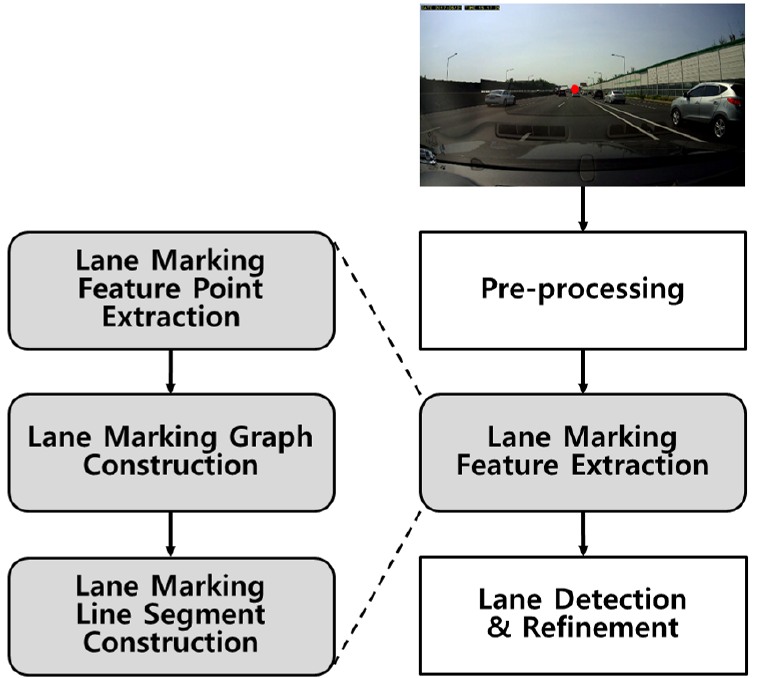
Figure 1. Block diagram of the proposed lane-marking feature extraction and lane detection meth- ods; the image is obtained by a mono-camera. The red point indicates the vanishing point of the lane